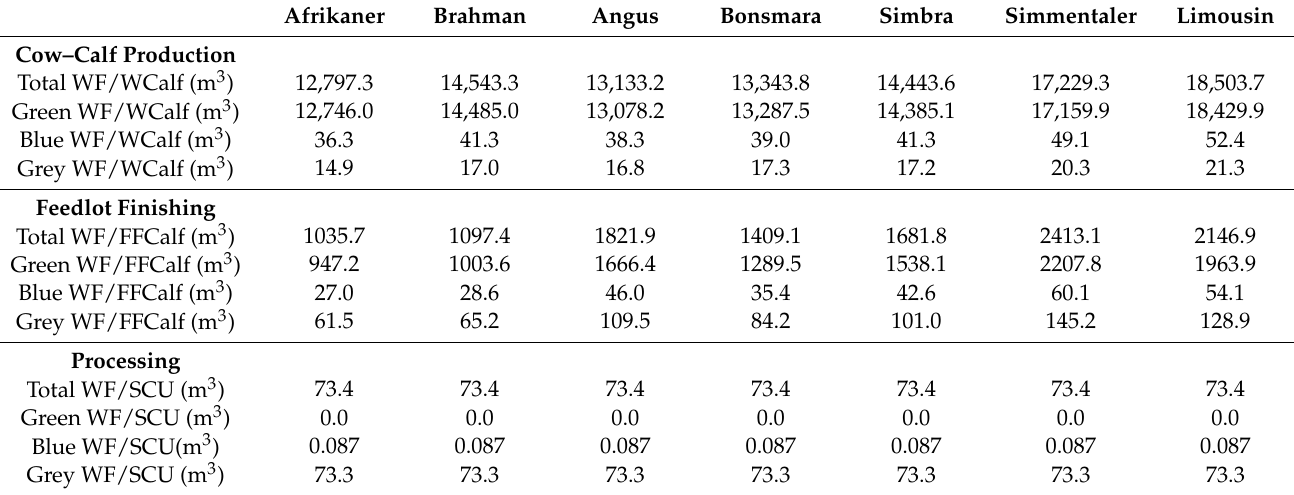
Table 1. WF of cow–calf production, feedlot finishing, and processing of